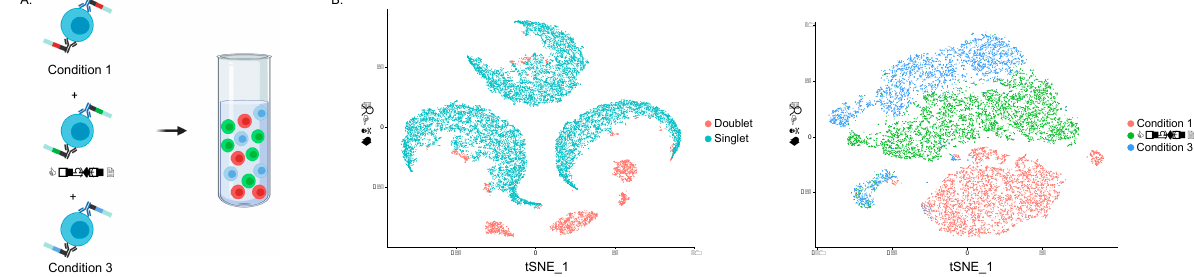
Figure 2. Cell hashing. To reduce batch effects and technical variations, cells from different conditions can be combined into one scRNAseq experiment and later demultiplexed. ( A ) Cells are labelled with identical antibodies to ubiquitous surface proteins bound to hashtag oligonucleotides (HTO) that comprise a common PCR handle (black) and poly-A tail (light blue) on either side of a 15-nucleotide sequence (red, green, or blue) that is unique to each experimental condition. ( B ) Cells that are positive for more than one HTO are annotated as doublets, and cells negative for all HTO are assumed to be empty droplets (ambient RNA). Singlets are then extracted, and tSNE plots generated from these hashtag count values, effectively identifying and clustering cells from each condition contained in the mixture.